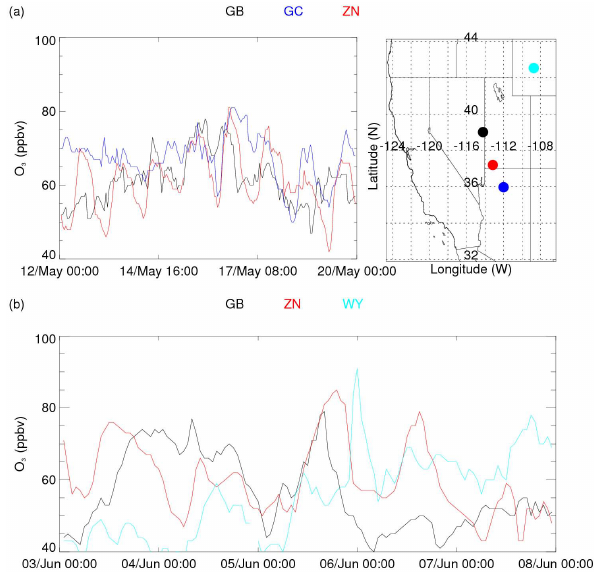
Fig. 12. O 3 time series from surface monitoring sites: Great Basin National Park, Nevada (GB, black); Grand Canyon National Park, Arizona (GC, blue); Zion National Park, Utah (ZN, red); and South Pass, Wyoming (WY, cyan), during 12–19 May 2012 (a) and 3–7 June 2012 (b)